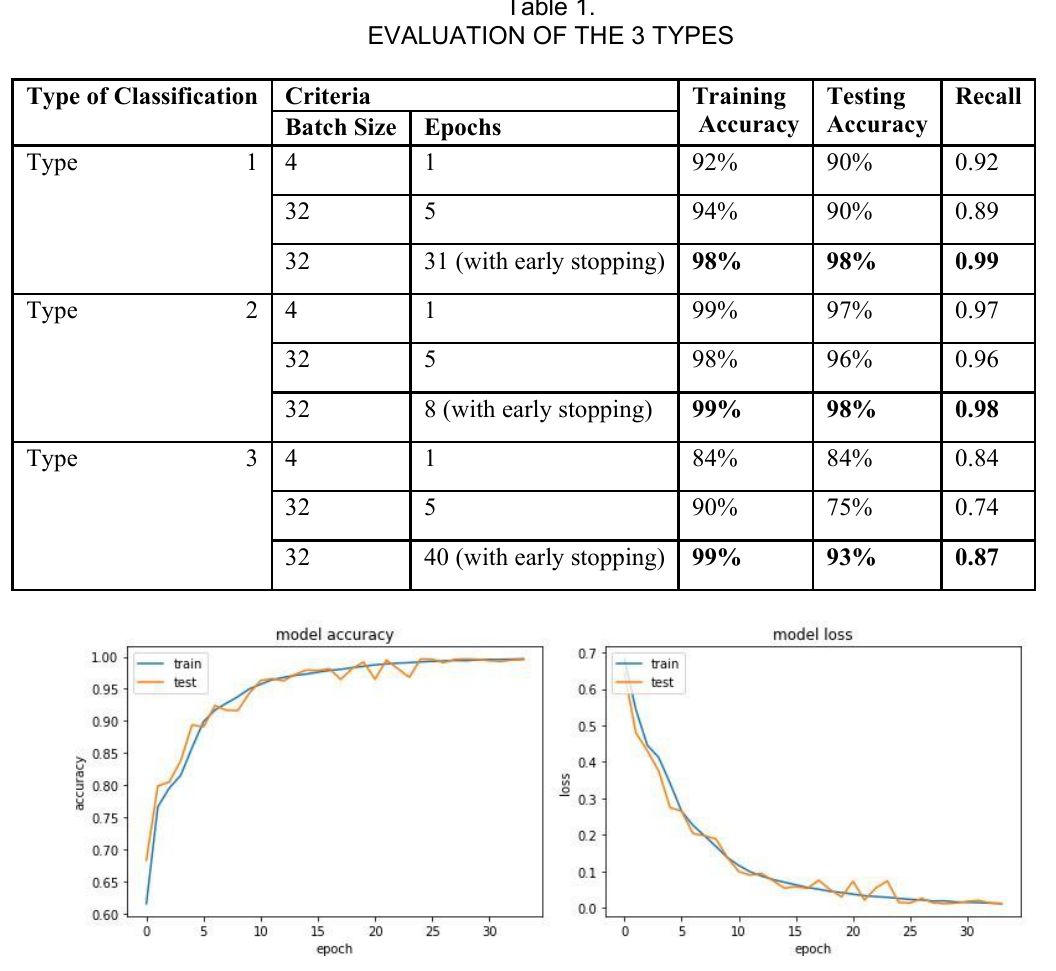
Fig. 8. Accuracy vs Epochs and Loss vs Epochs for training and testing of type 1.